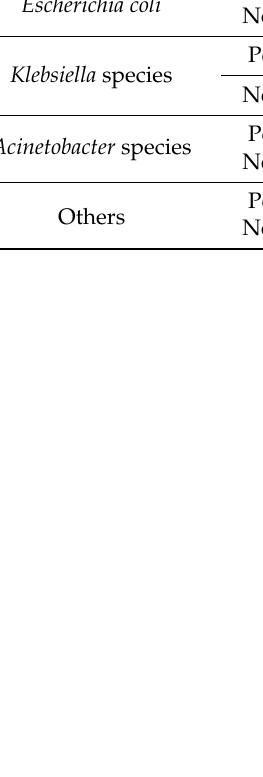
Table 4. Antibiotic resistance and presence of ESBLs-coding genes among clinical